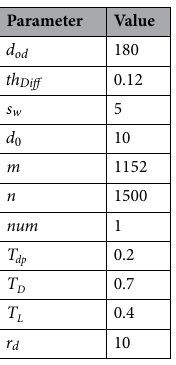
Table 1. The initial values for the required parameters.